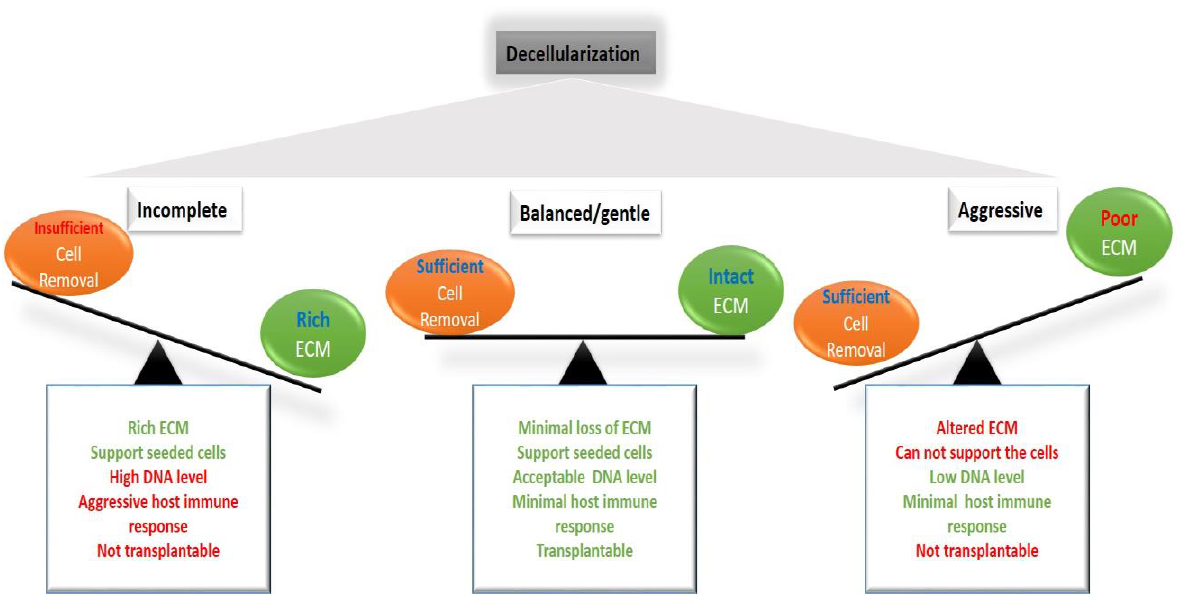
Figure 3. The effect of decellularization on the subsequent organ repopulation and organ transplantation potentials.